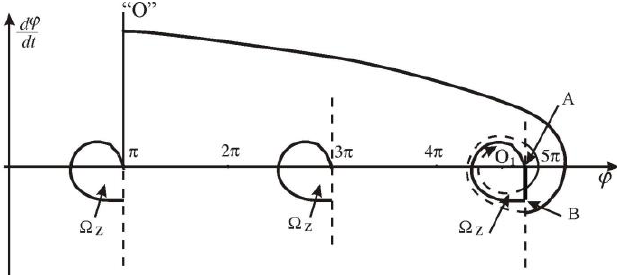
Fig. 5. Phase portraits in the PLL with additional processes with very large instantaneous frequency